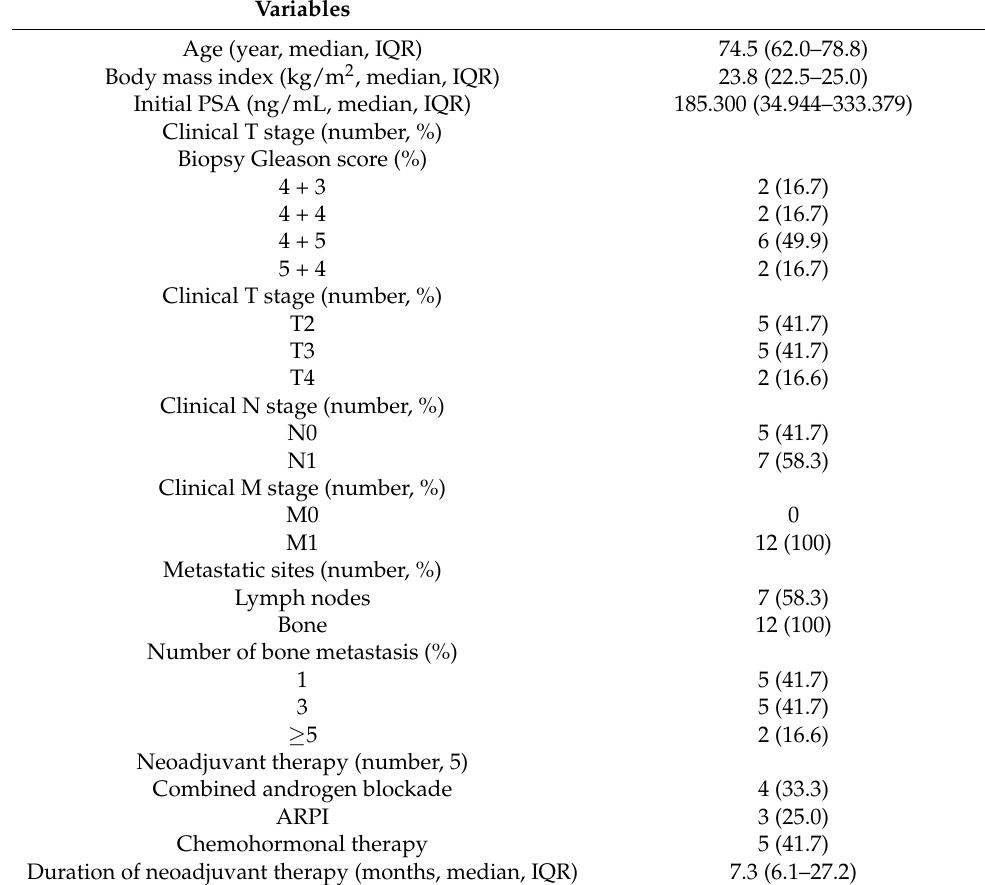
Table 1. Patient